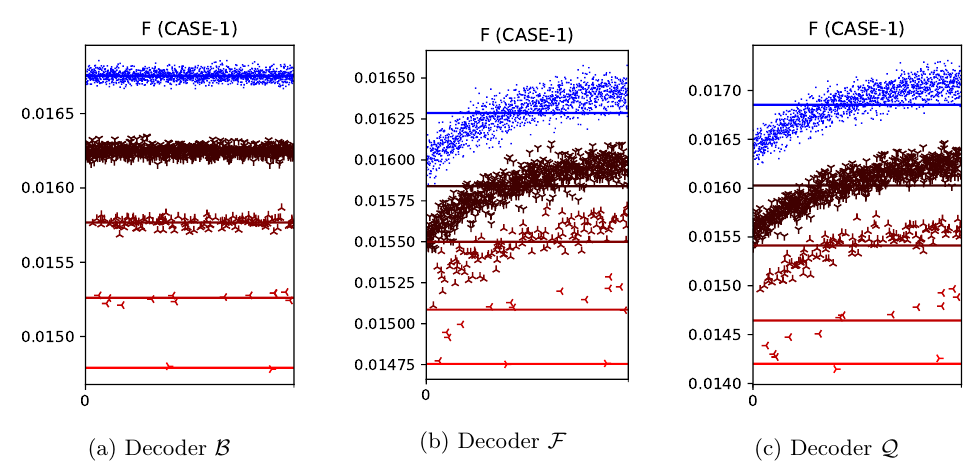
Figure 3: The plot for vector F for decoders B , F and Q . Multiplicity levels for each distance d ∈ D ( h 0 ) are easily distinguished. This data is based on 2 28 decoding attempts, for each decoder. Blue dots indicate distances that do not appear in h 0 (multiplicity 0). Dark markers indicate those distances that appear in h 0 once (multiplicity 1). Higher multiplicities are marked analogously with less dark shades of red and with different markers. The horizontal lines represent the average probability, for each multiplicity.